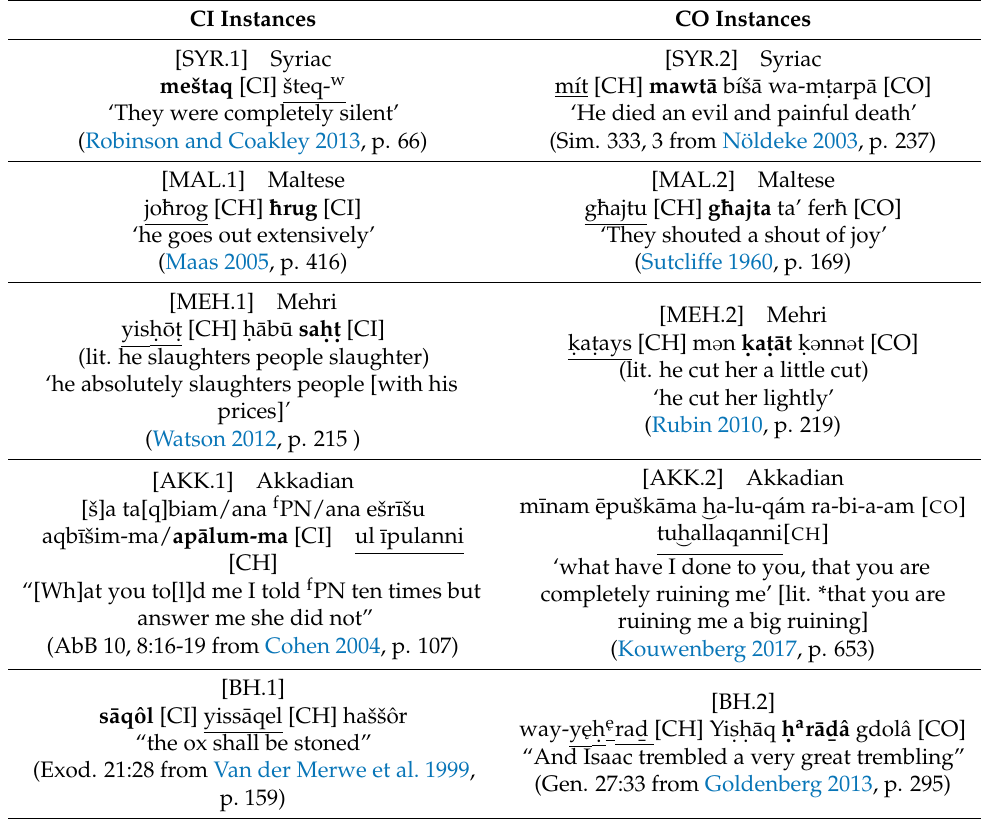
Table 2. CI and CO instances in different Semitic